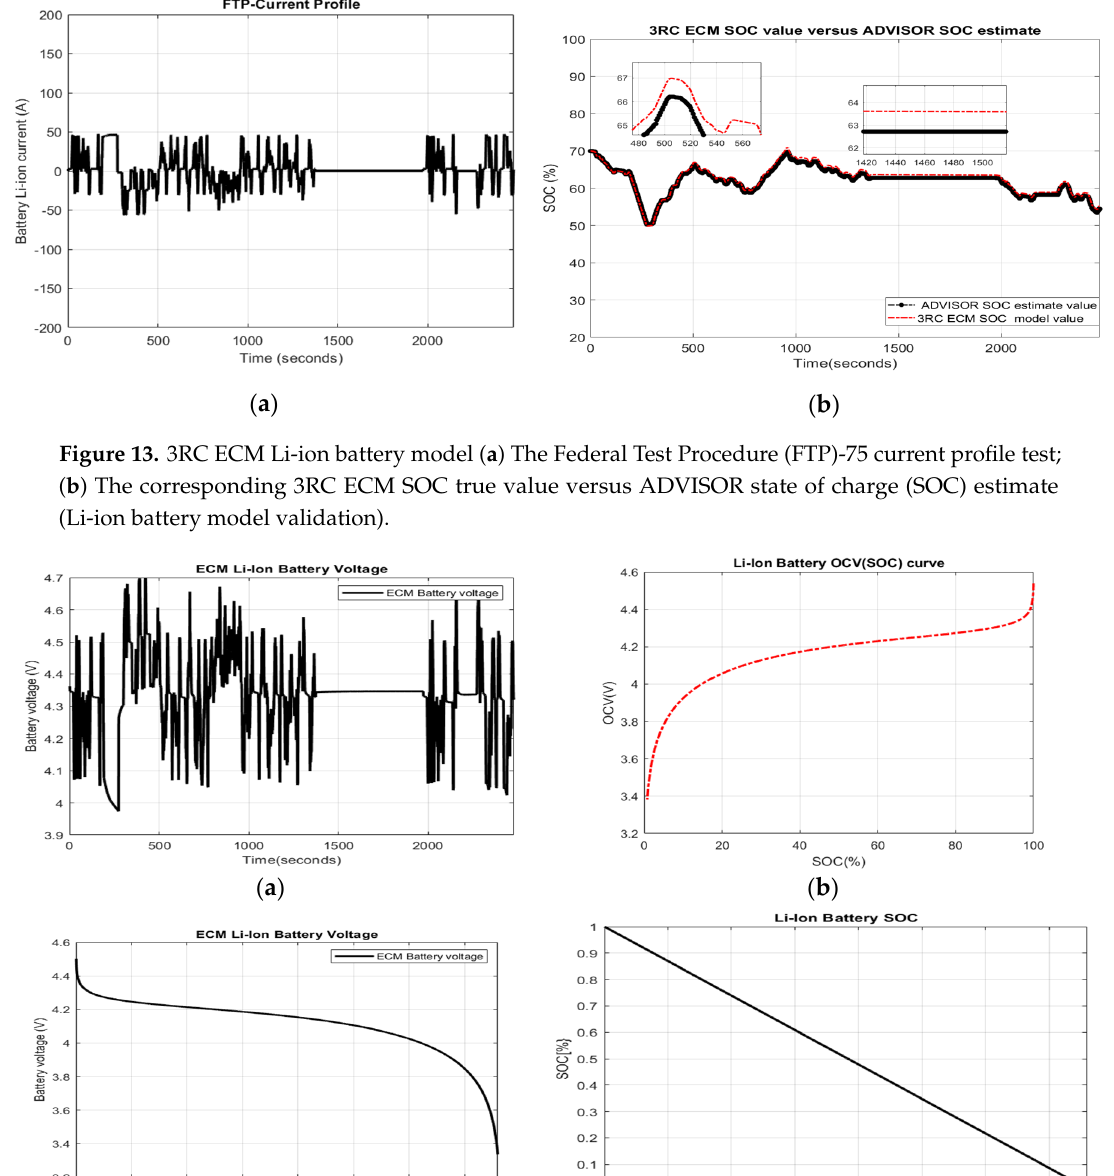
Figure 13. 3RC ECM Li-ion battery model ( a ) The Federal Test Procedure (FTP)-75 current profile test; ( b ) The corresponding 3RC ECM SOC true value versus ADVISOR state of charge (SOC) estimate (Li- ion battery model validation).